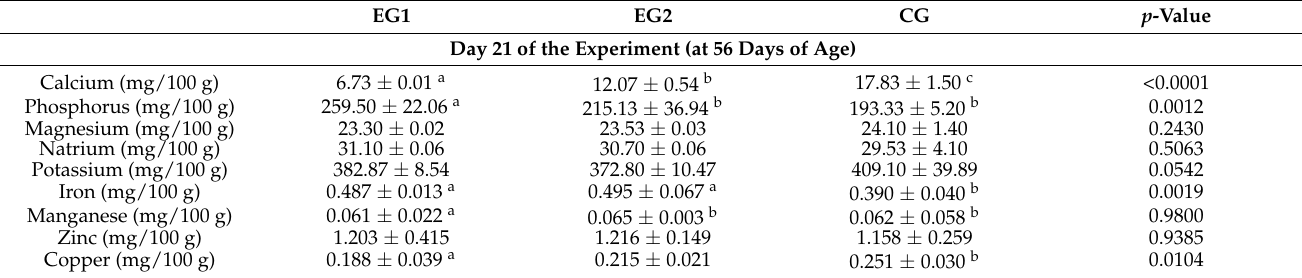
Table 2. Mineral levels (mg/100 g fresh matter/muscle, means ± SD) in Longissimus thoracis and lumborum of rabbits.